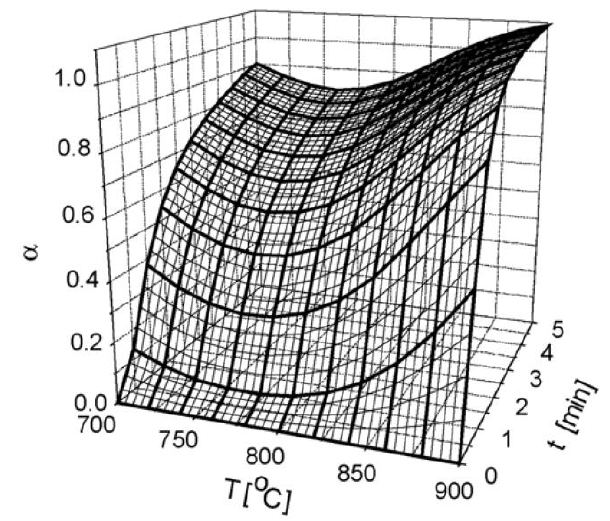
Figure 10. ANN (3-20-1) representation of the conversion degree for Fe 2 O 3 reduction in 90%N 2 + 5%CO + 5%H 2 gas flow [19]. Reprinted with permission from Elsevier.